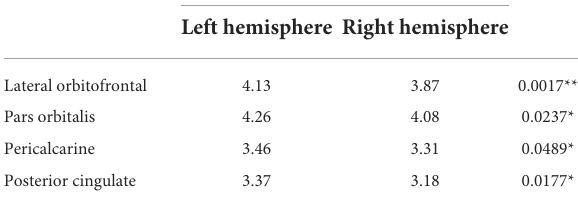
TABLE 4 Brain cortical regions that show significant asymmetry in cortical surface area (SA) in the GDD